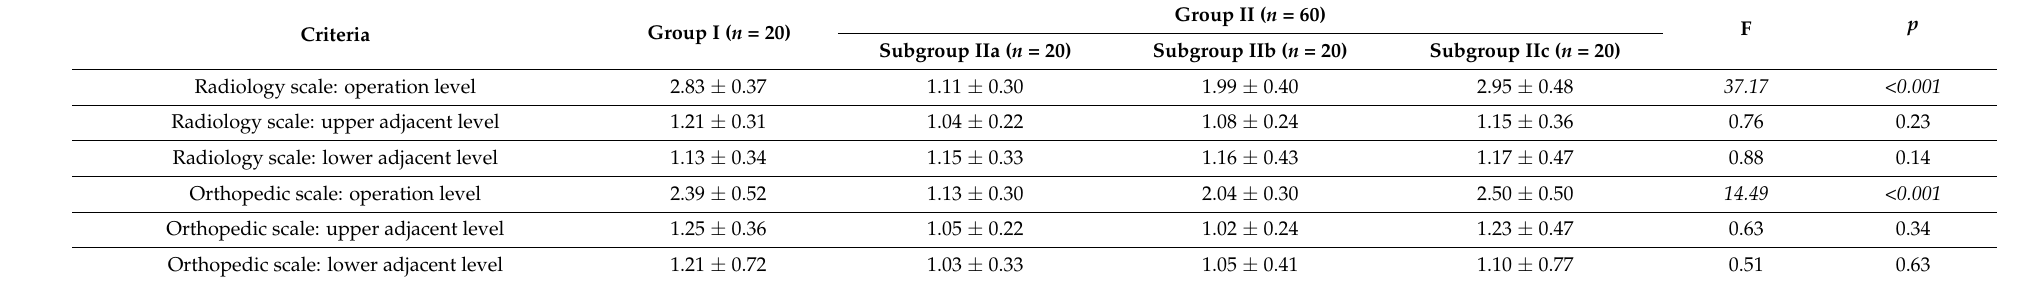
Table 5. Comparative assessment of the quality of postoperative MRI [13].